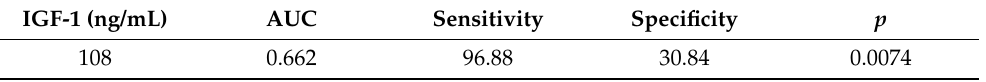
Table 3. Threshold of the IGF-1 level for a “decline in masticatory function”. IGF-1 (ng/mL) AUC Sensitivity Specificity